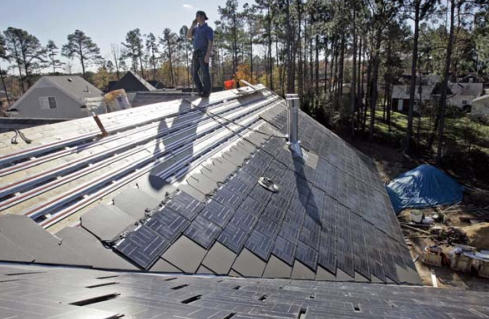
PV shinglesThin-film PV shingles are designed to blend in with regular asphalt shingles.